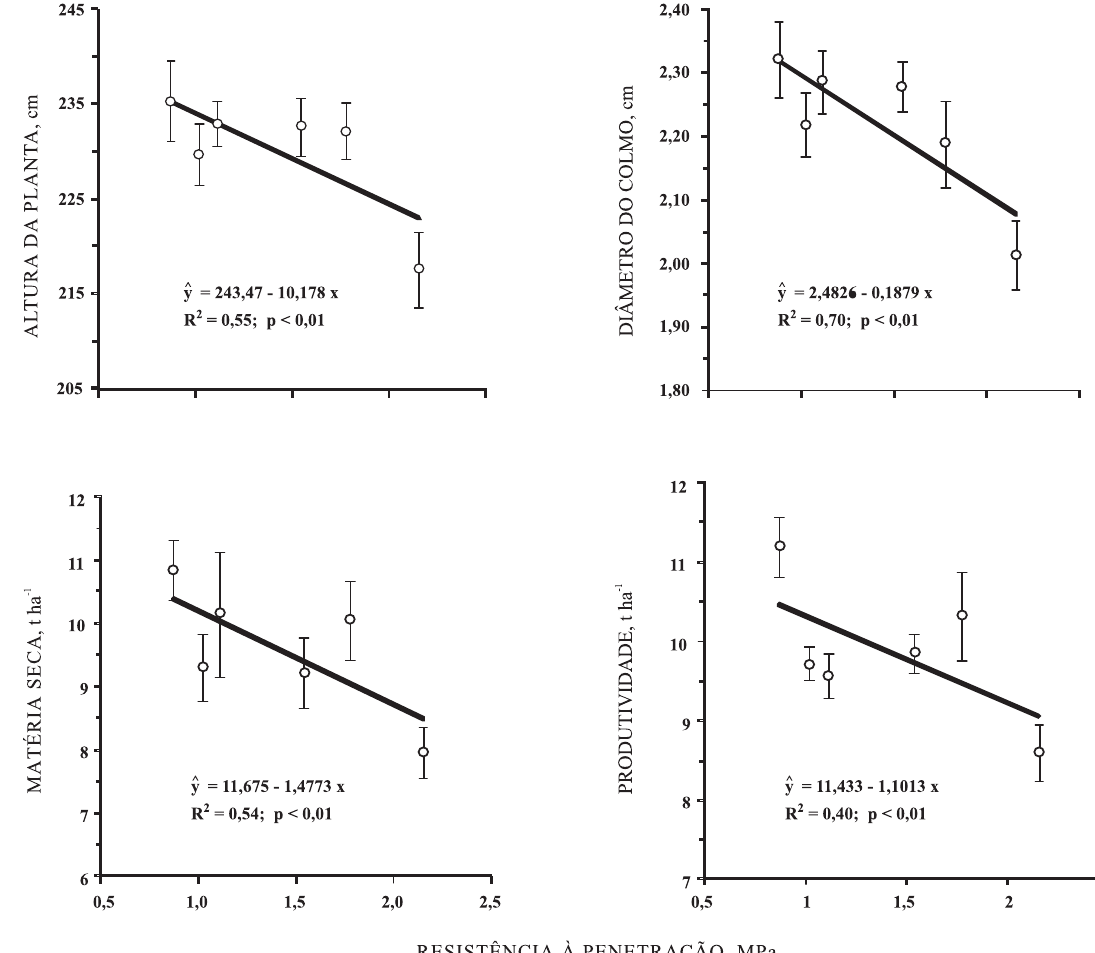
Figura 2. Regressão entre a resistência de um Latossolo Vermelho à penetração e a altura das plantas, diâmetro do segundo internódio do colmo, massa de matéria seca e produtividade do milho. As barras referem-se aos intervalos de confiança com os erros-padrão das